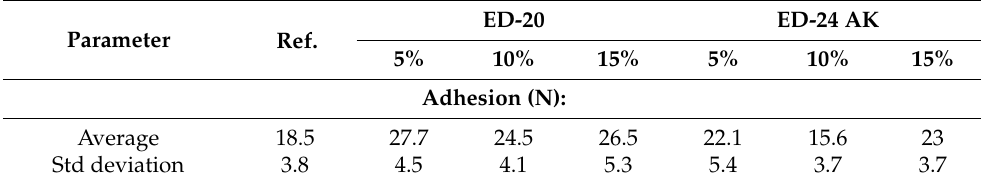
Table 4. Properties of adhesion to glass fibers of the rubber samples studied. Parameter Ref.